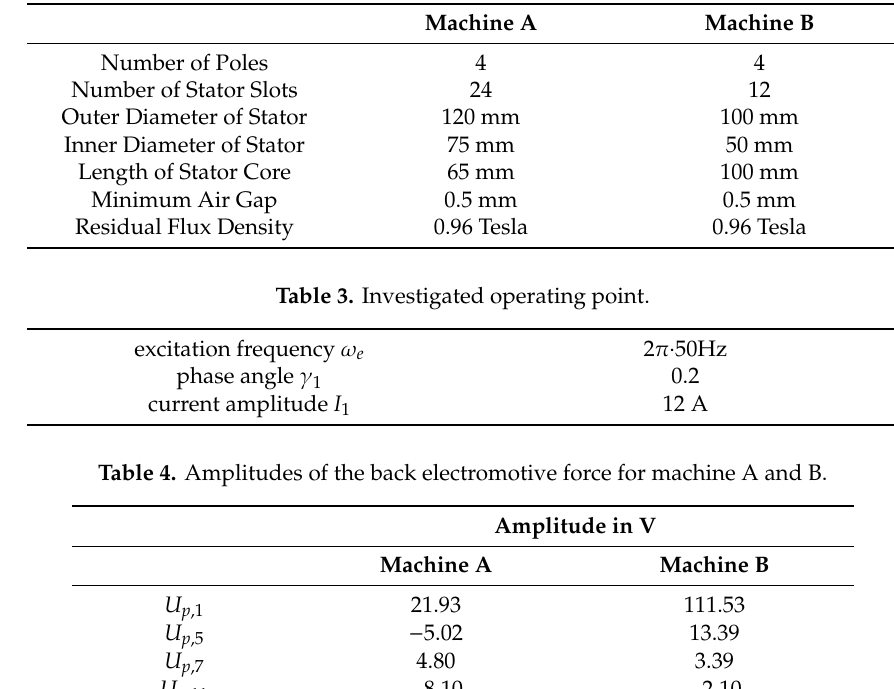
Table 2. Excerpt of the machine parameters from the simulation.